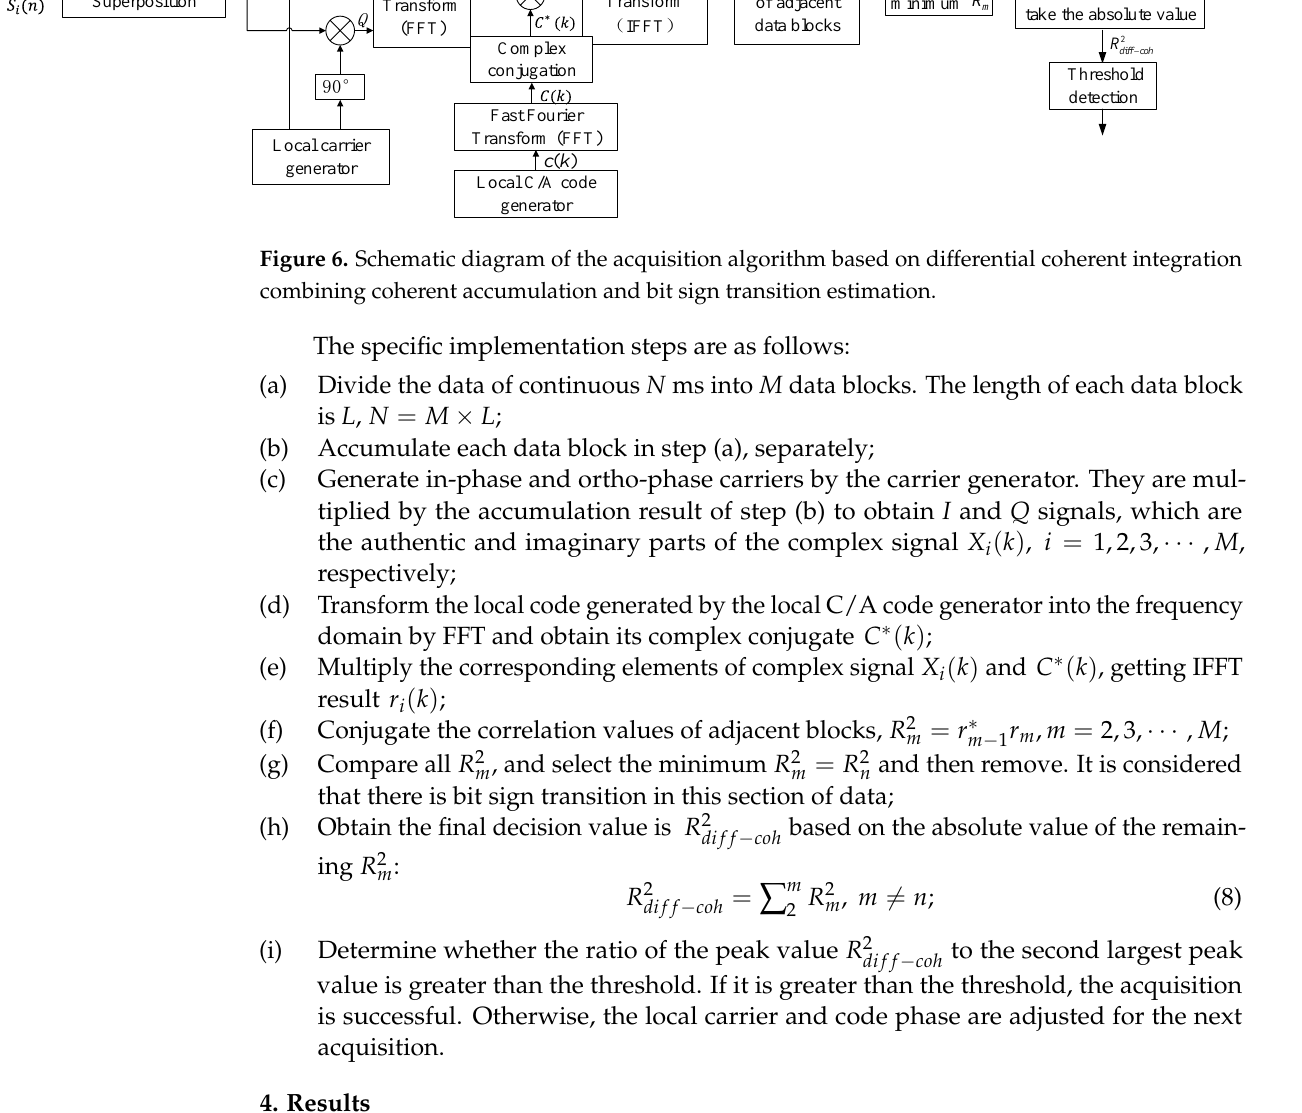
Table 1. Experimental acquisition algorithm-specific settings.